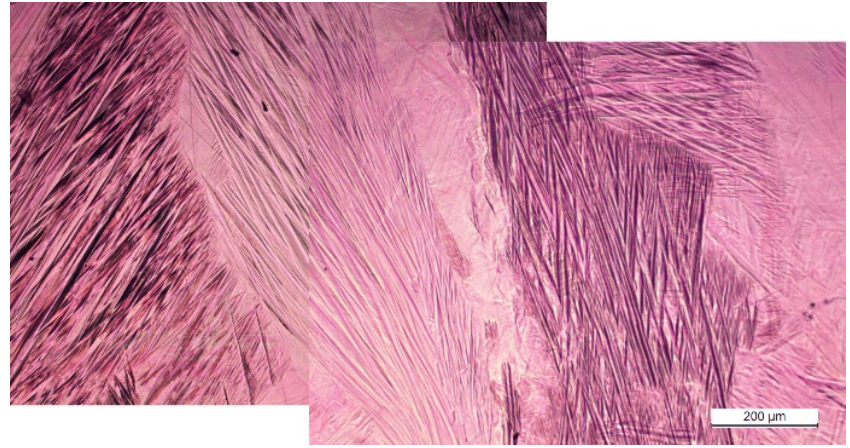
Figure 10. Optical microscopy by interferential contrast of the HIP–1 treated sample. The porosity is dramatically reduced and precipitates are not observed.